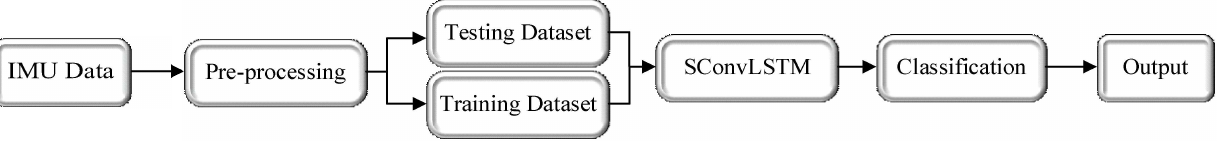
Figure 1. Main steps of IMU-based human activity